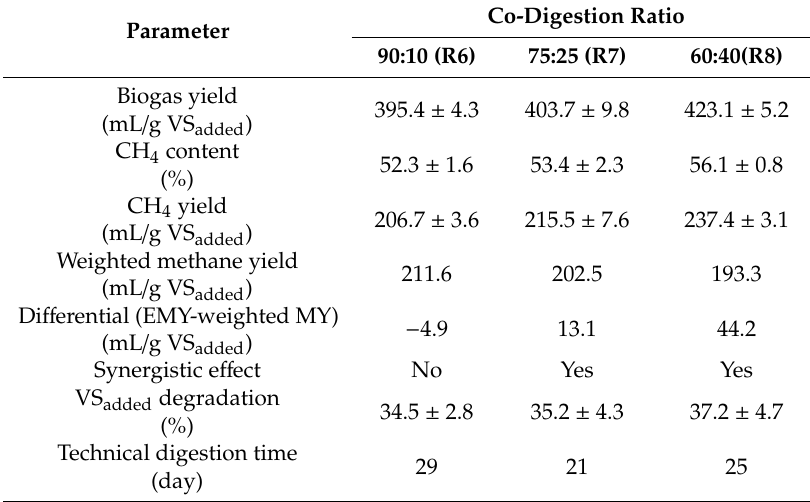
Table 4. Results from the co-digestion of potato peels with cow